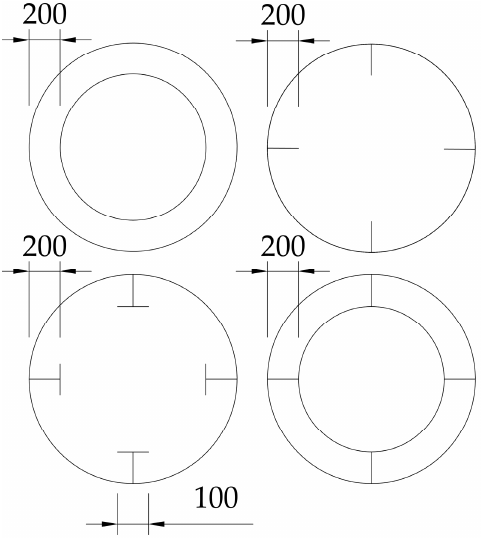
Figure 11. Geometric data of the sti ff eners in the cross-section view of the tower (in